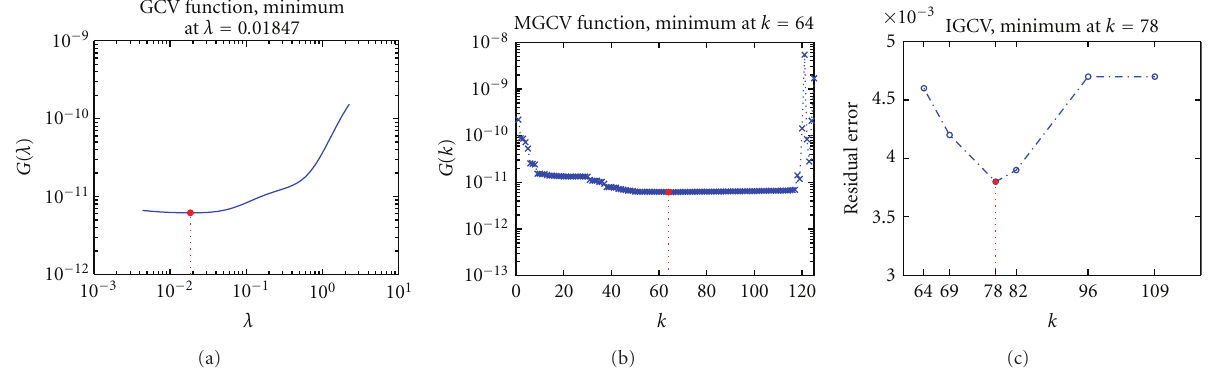
Figure 2: Regularization parameter determination in single-source case under measurement noise level of 10% and Gaussian system error level of 1%: (a) GCV function curve for Tikhonov, (b) MGCV function curve for TTLS, (c) illustration of the truncation parameter selection for TTLS with IGCV.